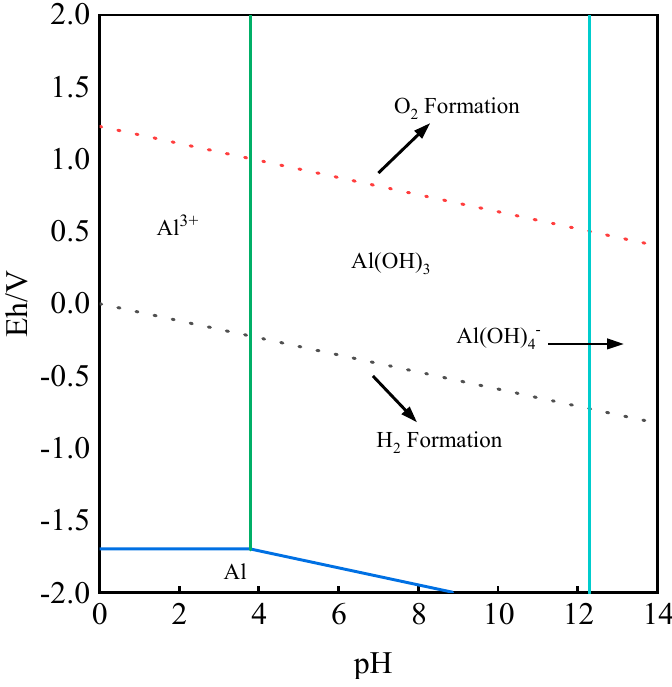
Figure 2. Eh–pH relationship of Al-H 2 O system.